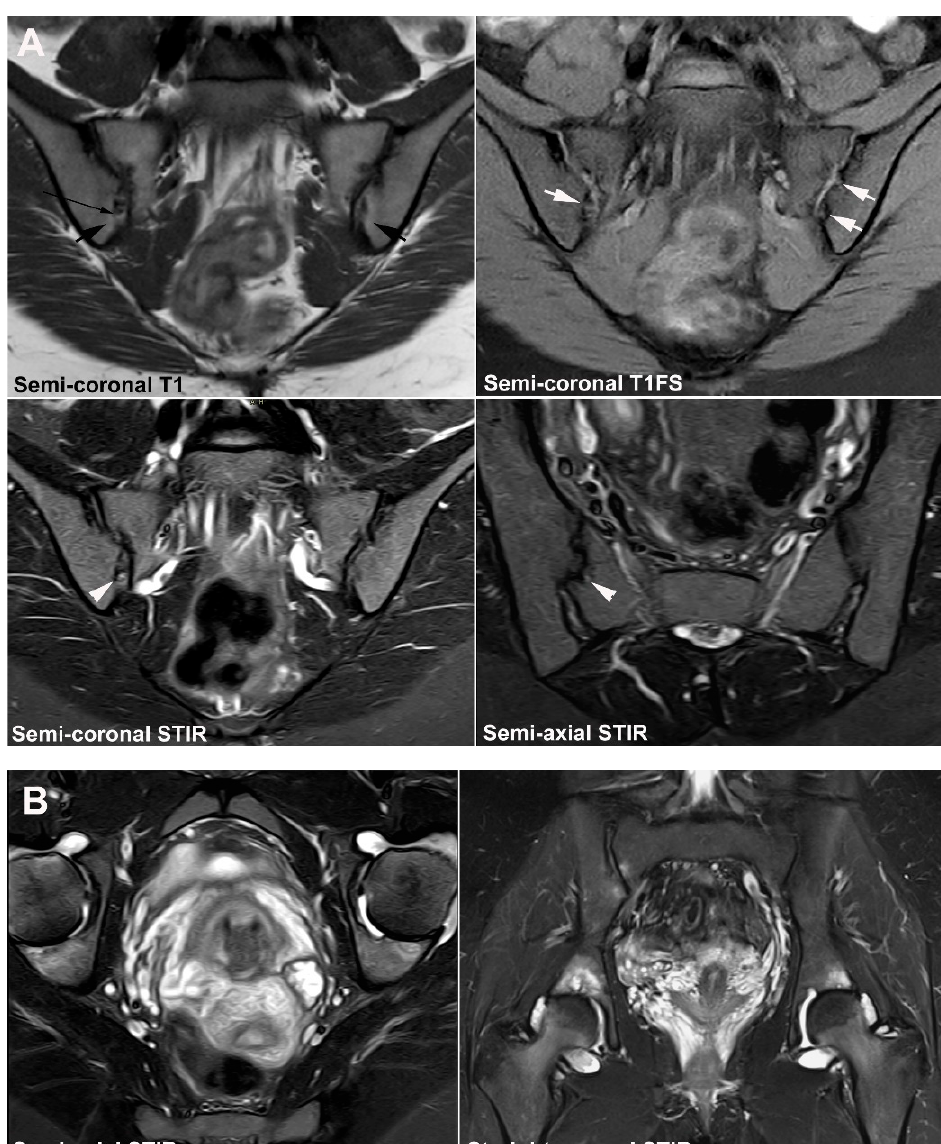
Figure 1. Predominant active sacroiliitis changes in a 31-year-old woman with inflammatory low back pain for 8 months, normal radiographic findings, CRP 22 mg/l (normal < 8 mg/L) and HLA B27 negative. Upper row of images: semi-coronal T1 and T1FS; lower row: semi-coronal STIR and semi- axial STIR images. There is manifest subchondral BME at the inferior part of the joints, especially on the right side (arrowheads), in addition to right-sided sacral erosions (white arrows) with an adjacent area of faint subchondral fat deposition (black arrow).